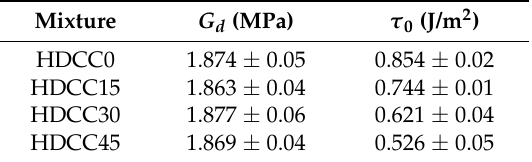
Table 4. Interfacial properties between the fiber and the